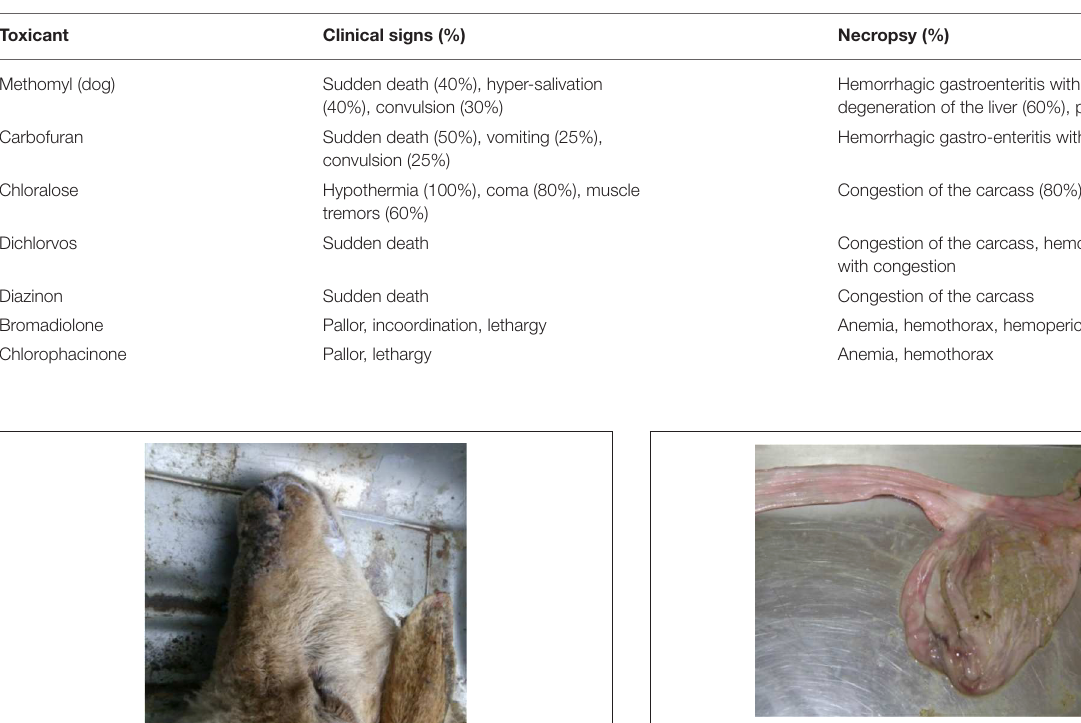
TABLE 3 | Clinical signs and necropsy of the most common toxicants involved in animal poisoning from 2014 to